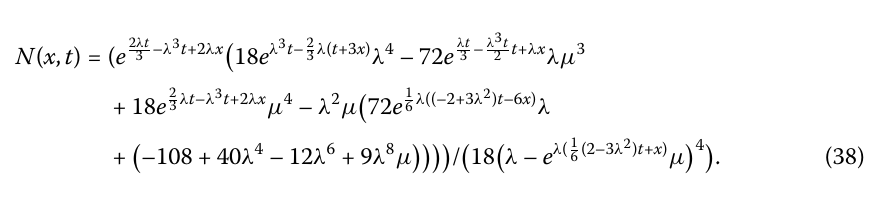
Table 2 Classification of r ( x , t ) surface at node points Node points (cid:10) N , N (cid:11) Class x = 0 –1166.57